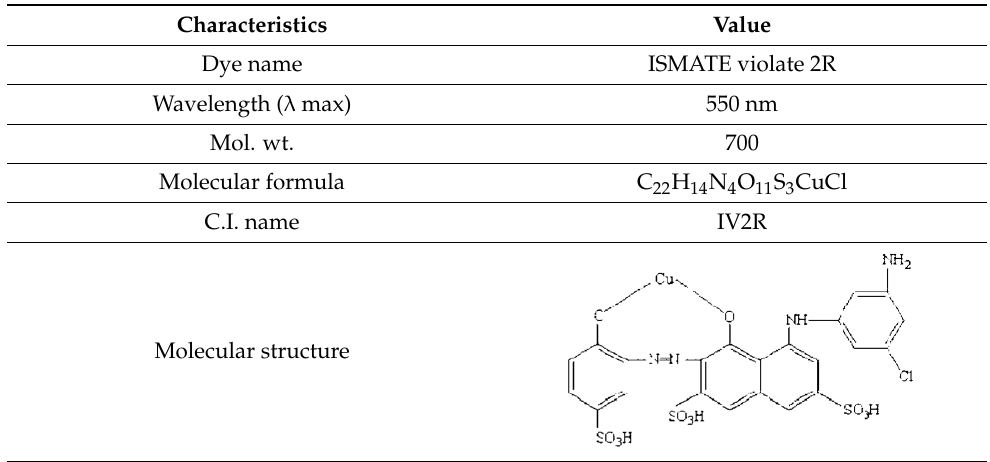
Table 1. Chemical and physical characteristics of the ISMATE violate 2R dye [28]. Characteristics